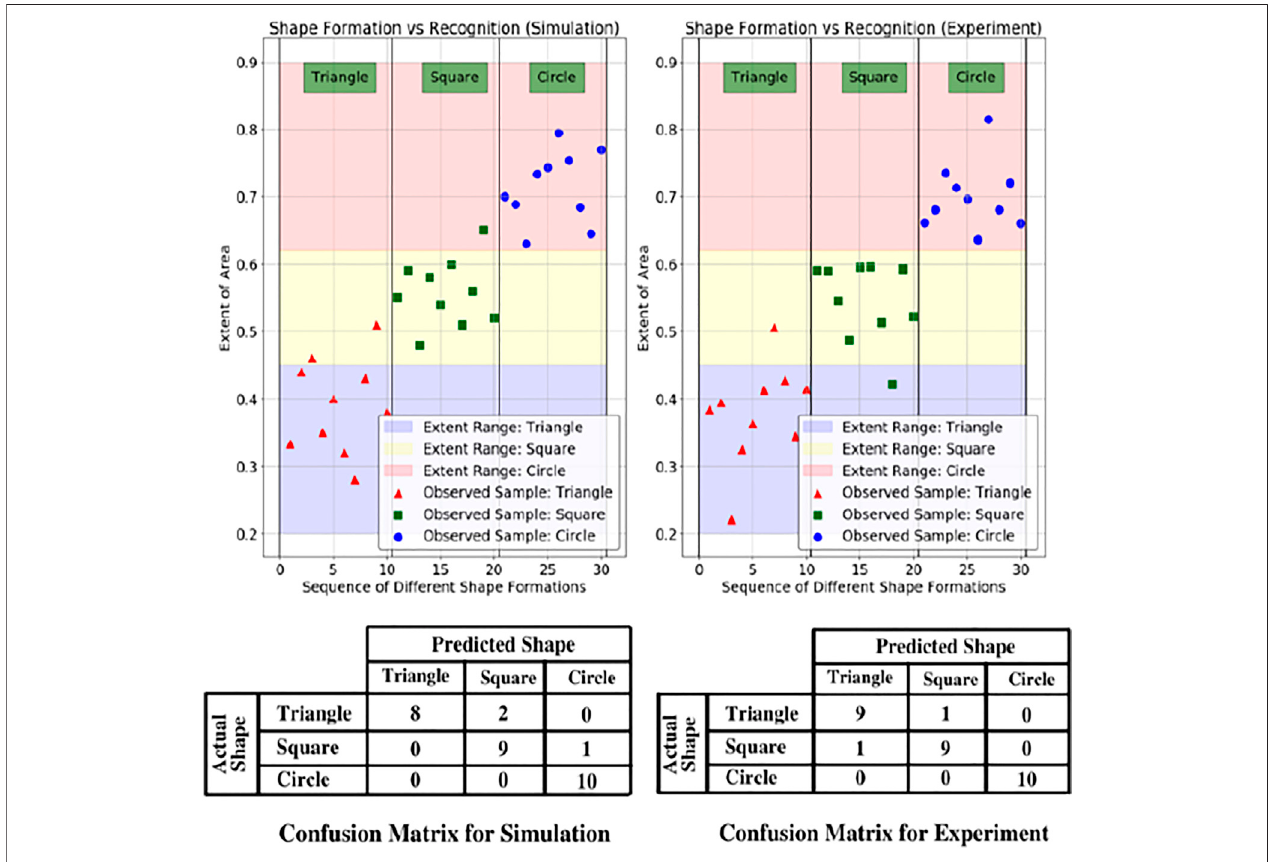
FIGURE9| Sampledatafromsimulationandexperimentfortheextentofareacoveredandrangesforthecorrespondingshape.Thepink,yellowandpurpleareas are the empirical regions for the classi fi cation of shapes. Below the fi gure are the confusion matrices for the related scenarios.